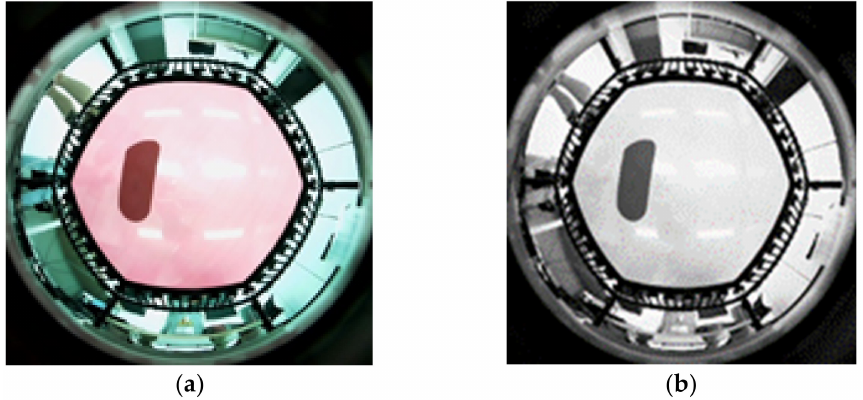
Figure 4. The input image. ( a ) Source image. ( b ) Preprocessing input